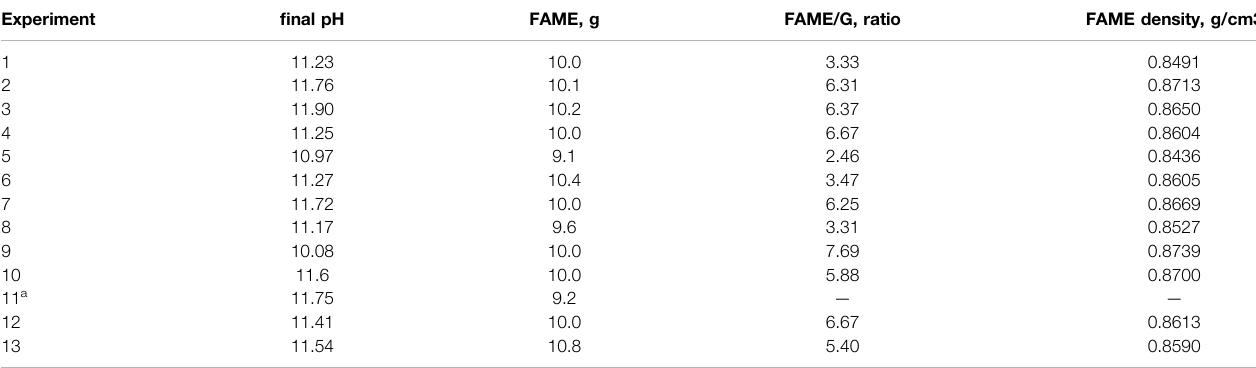
TABLE 3 | Experimental results from the 2 4 − 1 design of experiments. Experiment